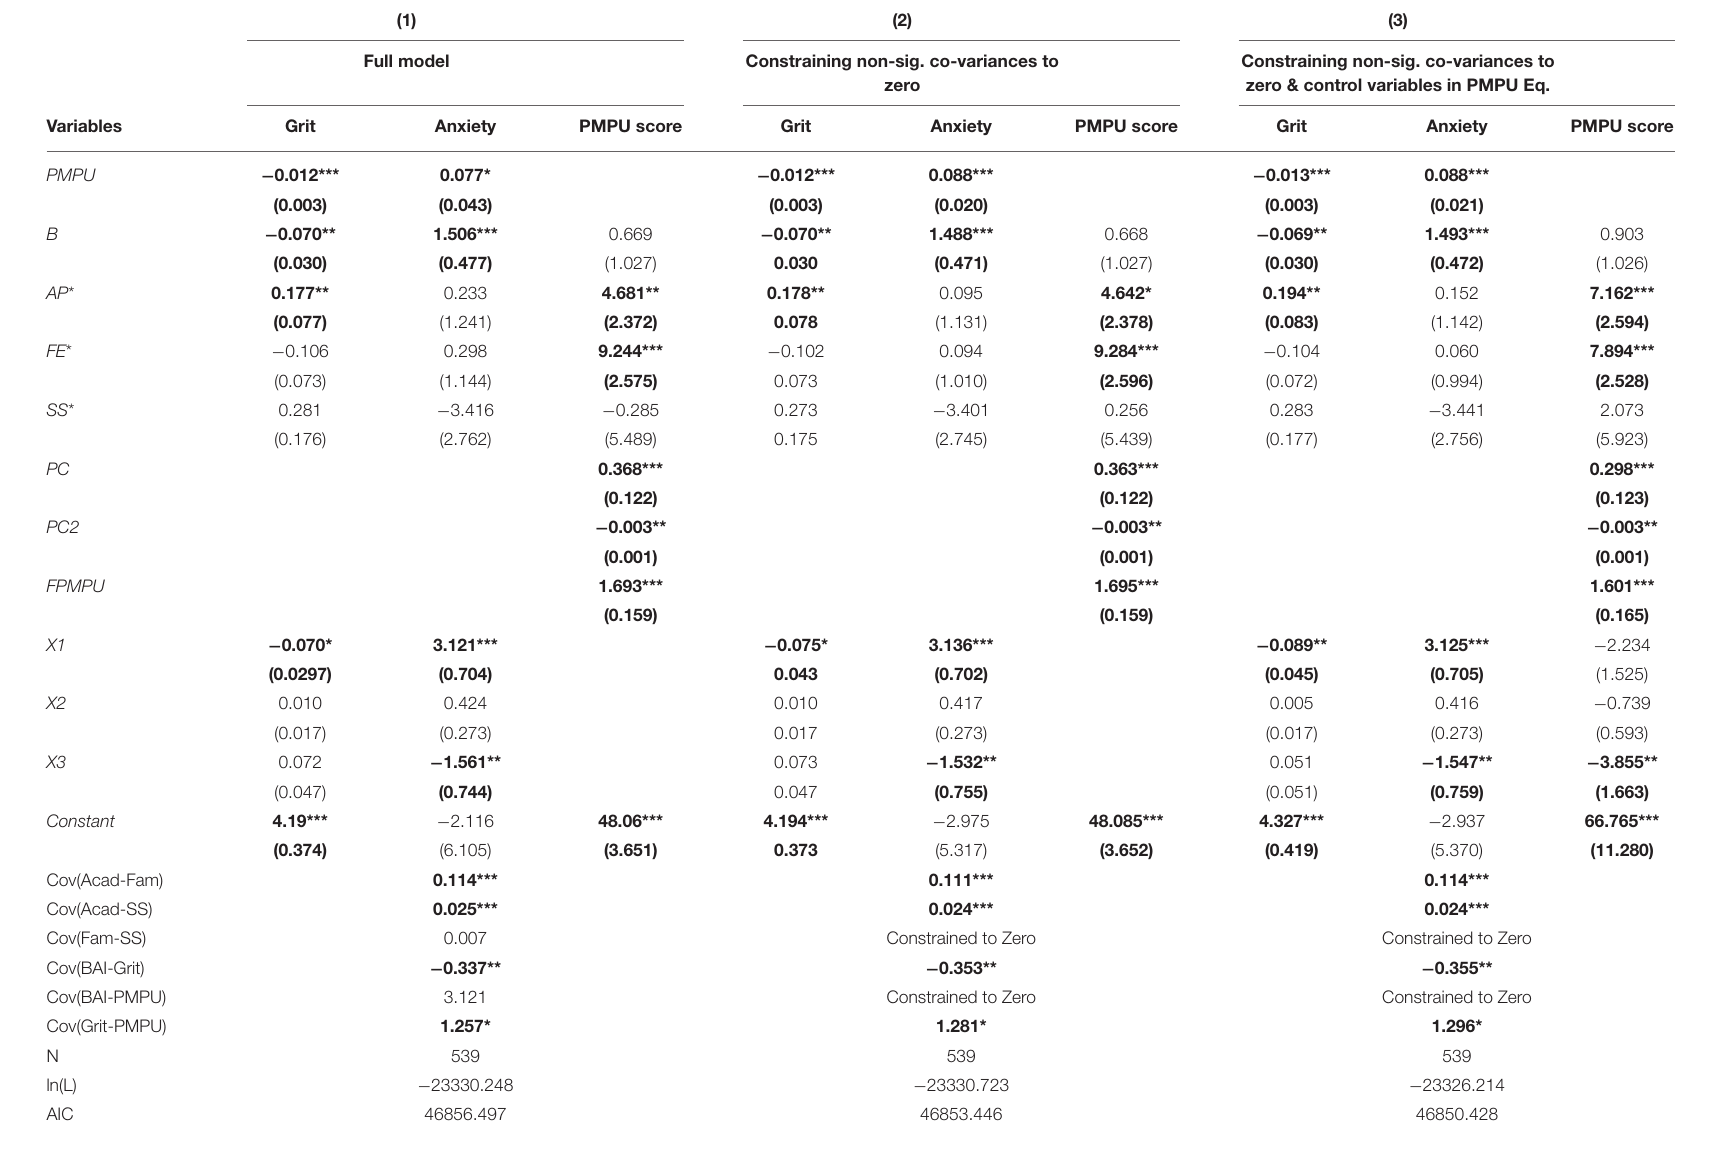
TABLE 2 | Results of linear probability estimation for structural model of adolescent life influences on